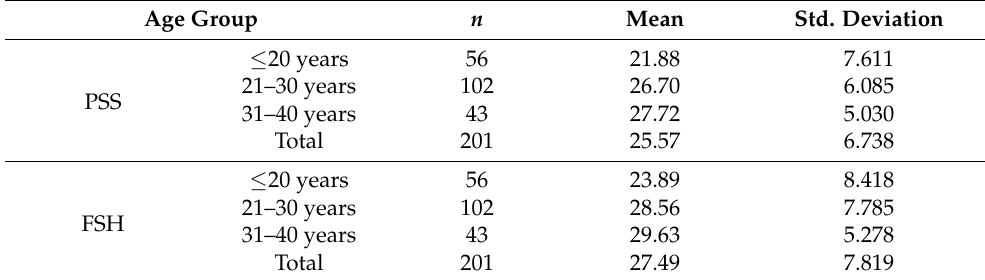
Table 4. Mean distribution of personal safety and sexual harassment regarding the age of the participants [ n = 201].